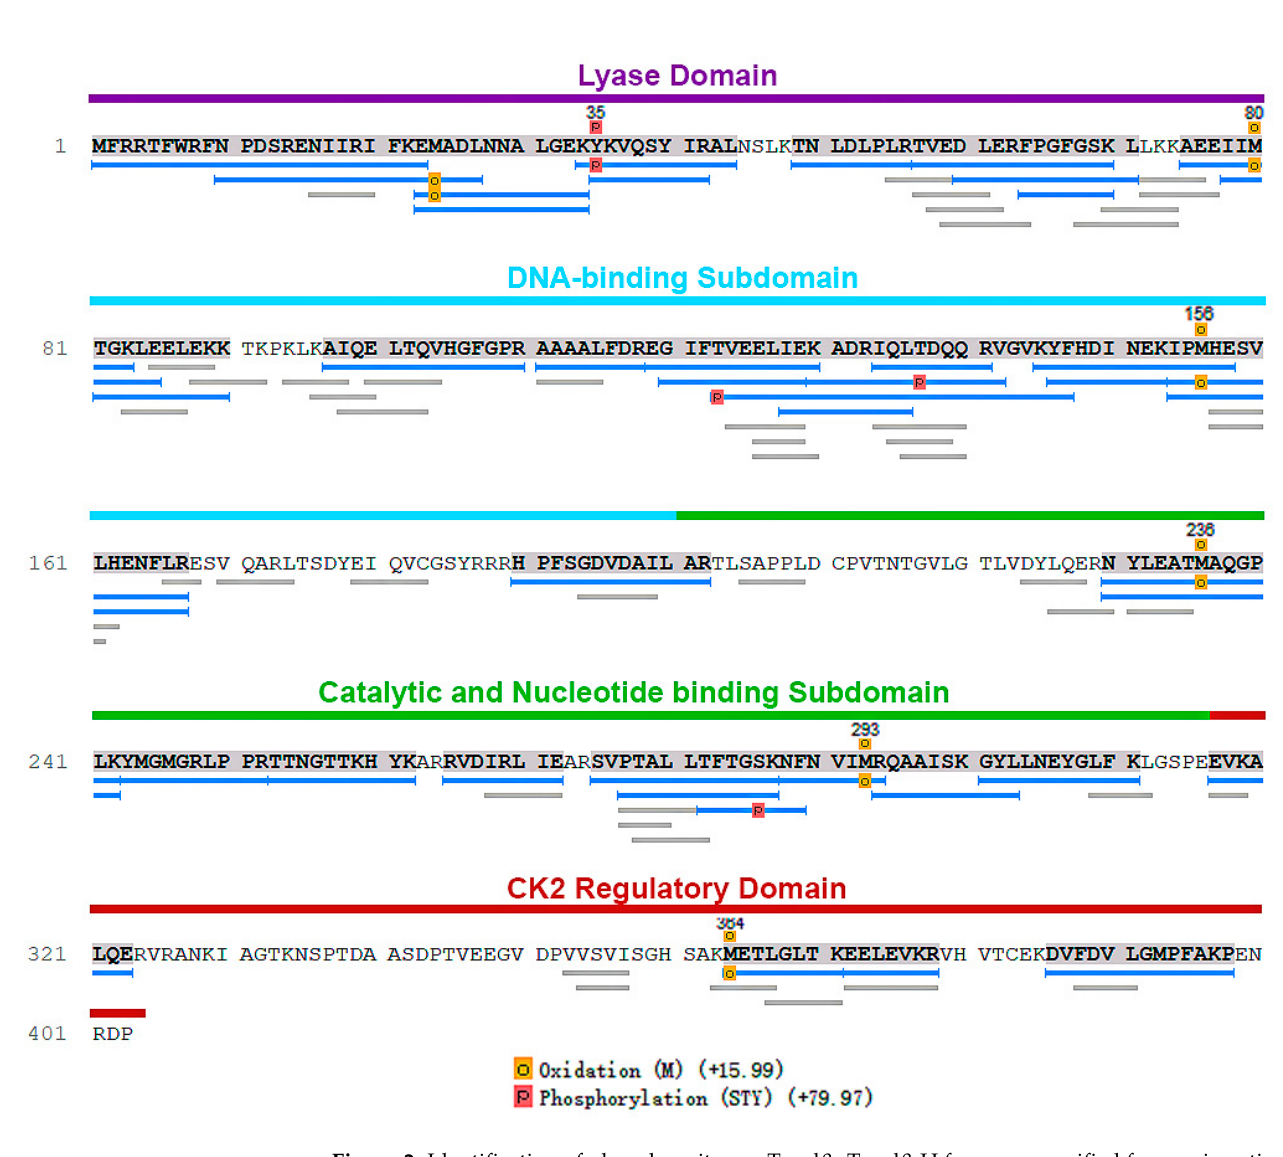
Figure 2. Identification of phosphor sites on Tcpol β . Tcpol β H form was purified from epimastigotes cell extracts by antibody affinity chromatography. The concentrated eluates were subjected to SDS-PAGE (10% gel) and Coomassie Blue R-250 staining. The band corresponding to Tcpol β H form (20 μ g) was cut out from the gel and treated with two proteases. The phosphor peptides were analyzed by LC-MS/MS spectrometry at Creative proteomics. The sequenced peptides are shown and the position of phosphorylated Ser, Tyr and Thr residues are shown. The different domains of Tcpol β are shown over the amino acid sequence. It can be observed that in the middle and at the CK2 regulatory domain of the polypeptide there was not good peptide coverage, therefore some in vivo phosphorylation sites might be missing from the analysis. The Tyr35 can be phosphorylated by an unidentified dual protein kinase. Thr123 is phosphorylated by CK2. Thr137 and Ser286 are phosphorylated by